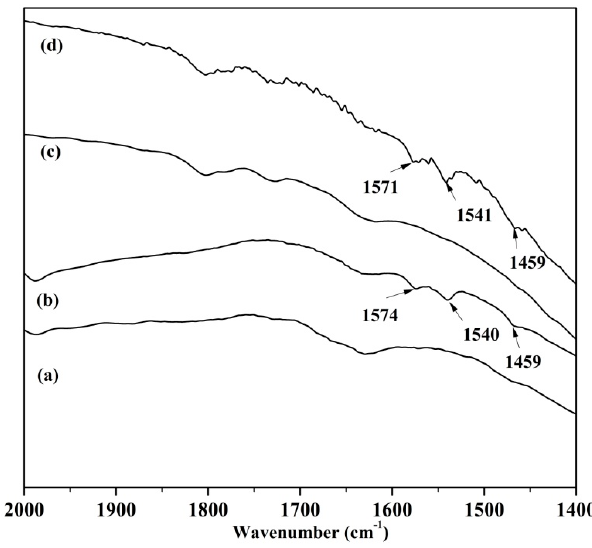
Figure 7. The enlarged spectra of kyanite ( a ), kyanite treated with sodium oleate ( b ), sillimanite ( c ) and sillimanite treated with sodium oleate ( d